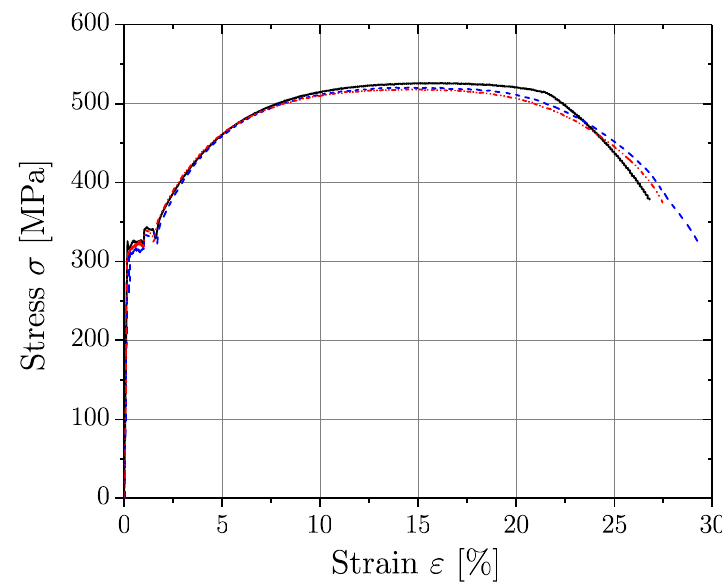
Figure 4. Quasi-static tensile test results.